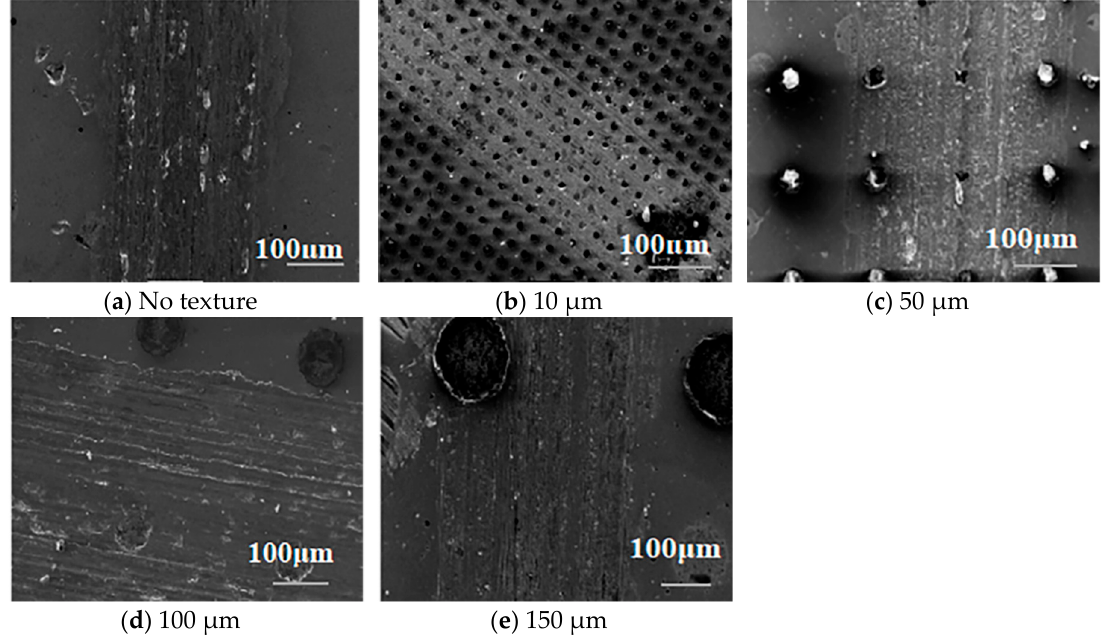
Figure 5. Microscopic morphology of wear scars of different pit diameters under oil shortage.